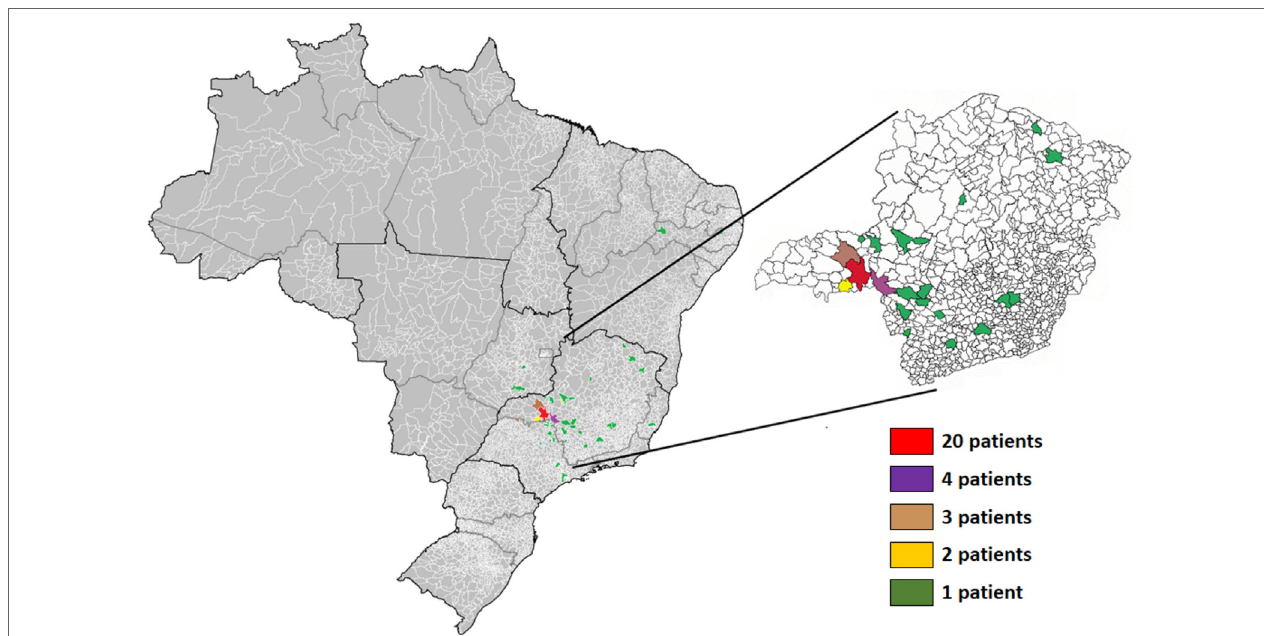
FigUre 1 | Geographical distribution of patients with the endemic form (fogo selvagem) of pemphigus foliaceus. The respective colors represent the number of patients from each municipality. Highlight to the state of Minas